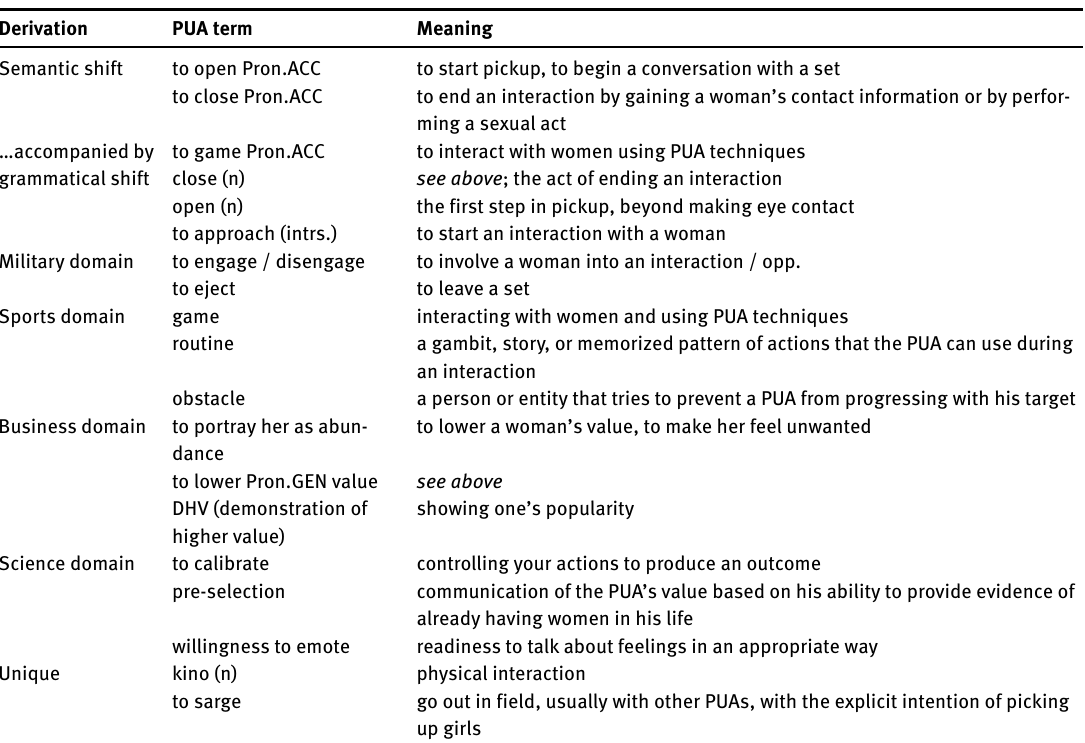
Table 1. PUA terminology and its